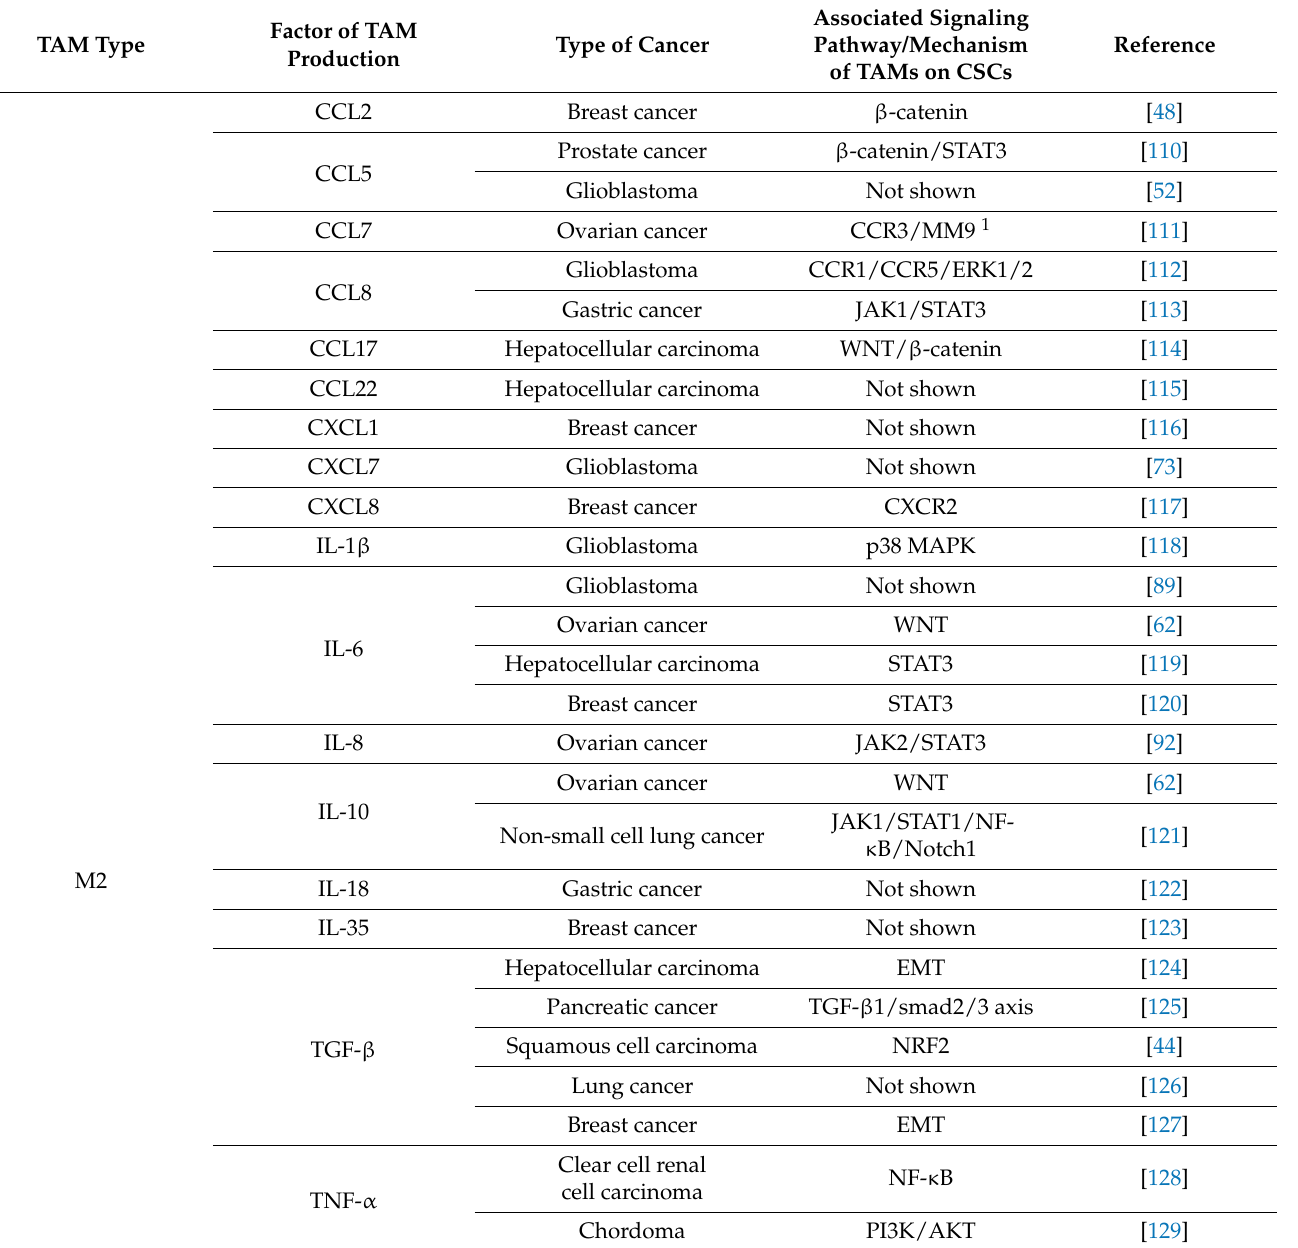
Table 3. TAMs secreted molecules to enhance the properties of